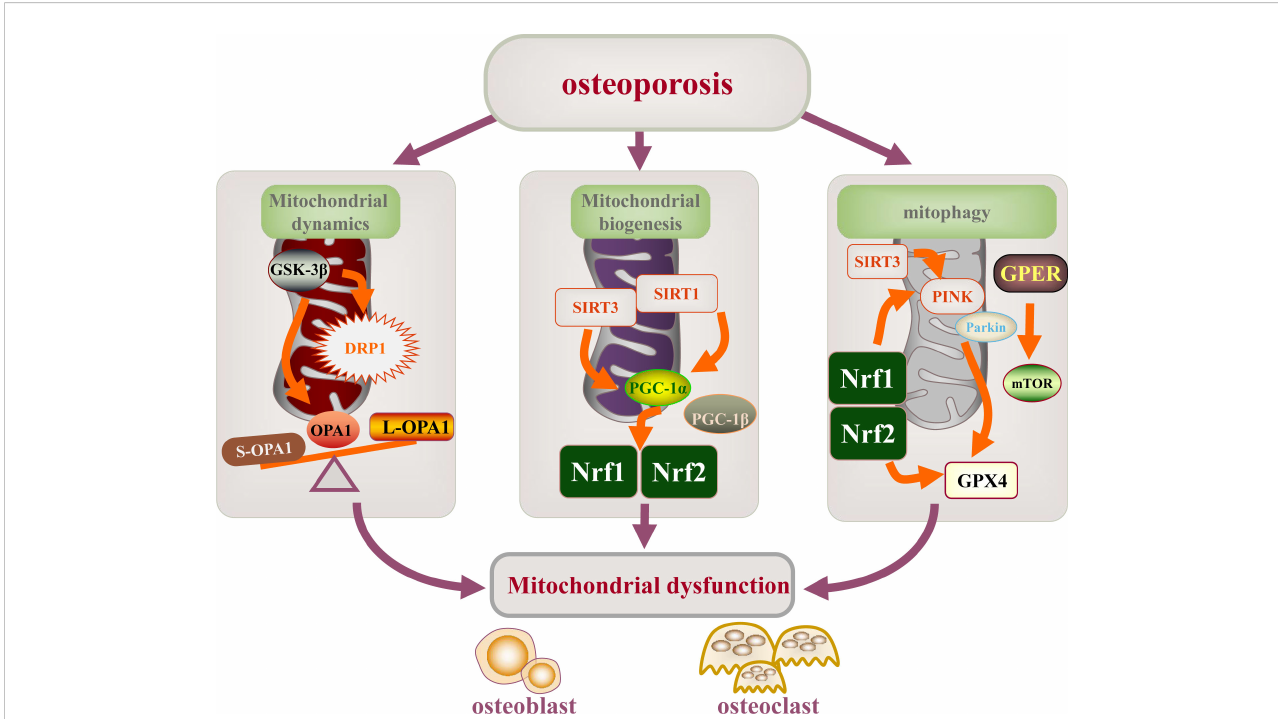
FIGURE 5 Mitochondrial dysfunction is involved in the mechanism of osteoporosis. Mitochondrial dysfunction (mitochondrial dynamics, mitochondrial biogenesis, and mitophagy) leading to the development and progression of osteoporosis. The main targets of mitochondrial dysfunction are DRP1, OPA1, GSK-3 b , mTOR, SIRT1/3, PGC-1 a , NRF2/2, PINK1, and